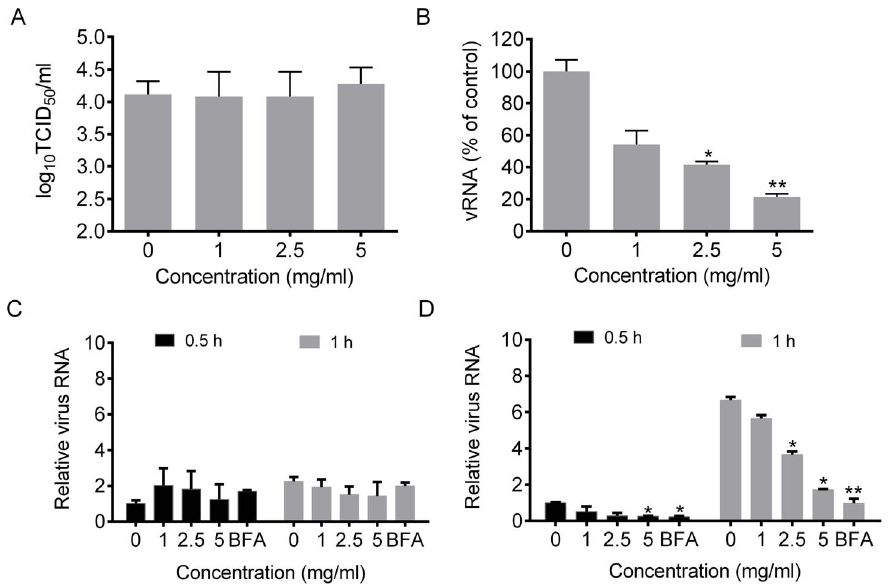
Figure 3. Cryptoporus volvatus extract inhibits influenza virus entry into and release from MDCK cells but not attachment. (A) Effects of the Cryptoporus volvatus extract on virus attachment. MDCK cells were incubated with various concentrations of the Cryptoporus volvatus extract and A/WSN (MOI of 2) at 4 ˚ C for 2 h. After cells were washed 6 times with PBS to remove unattached virus, cell lysates were prepared by rapid freeze thaw. Virus titer was determined in MDCK cells. (B) Inhibition of influenza virus entry by the Cryptoporus volvatus extract. MDCK cells were incubated with A/WSN (MOI of 10) at 4 ˚ C for 2 h. The inoculum was then aspirated, and cell monolayer was washed with cold PBS, replaced with fresh DMEM medium containing various concentrations of the extract or normal saline control, and switched the temperature to 37 ˚ C. At 1 h post switching to 37 ˚ C, cells were washed twice with acidic PBS-HCl (pH1.3) to remove any un-internalized viral particles on the cell surface, followed by washing twice with PBS. Intracelluar virus was analyzed by quantified M1 gene using Real-Time RT-PCR and the quantity of virus in the control group was set up at 100%. Determination of viral RNA intracellular (C) or released to the supernatants (D). MDCK cells were infected with A/WSN (MOI of 0.1) for 10 h. After washing with PBS, cells were treated with either Cryptoporus volvatus extract or BFA (a known inhibitor of protein transport) for 0.5 or 1 h, and then copies of viral RNA in the supernatants and in the cells were determined using quantitative real-time RT-PCR assay. The relative quantities of viral RNA compared to the control at 0.5 h post treatment (set up as 1) were shown. Results shown are the averages from three independent experiments (mean ¡ SEM). Statistical significance was analyzed by One-way ANOVA. * P , 0.05 ; ** P , 0.01